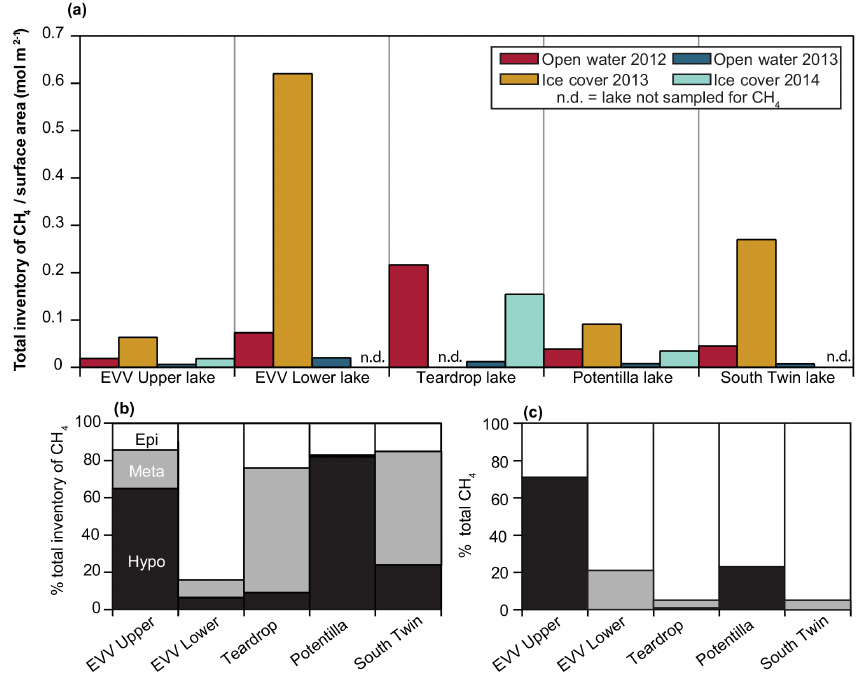
Figure 9. (a) Total inventory (moles) of CH 4 in the water column of each lake under both open-water conditions in July 2012 (black) and July 2013 (grey) and ice-covered conditions in April 2013 (white) and April 2014 (hashed lines). For seasons where the inventory was low, total moles are written above the bars; n.d. refers to seasons when a given lake was not measured. (b, c) Relative pool sizes (% of total) of dissolved CH 4 under open-water conditions in July 2012 (b) and July 2013 (c) . Pools are defined by redox conditions, where the stored pool (black) is the sum of CH 4 from intervals where DO<1mgL − 1 , gray represents the suboxic pool, and the active pool (white) is the sum of CH 4 from well-mixed surface intervals potentially available for direct exchange with the